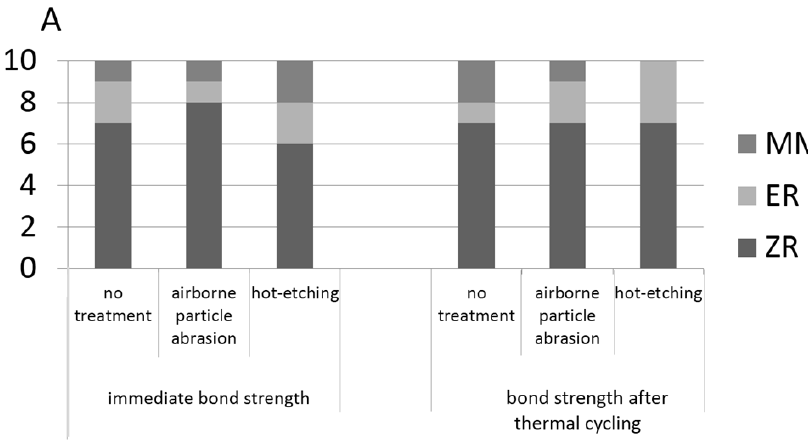
Figure 2. Cont. Figure 2. Cont.